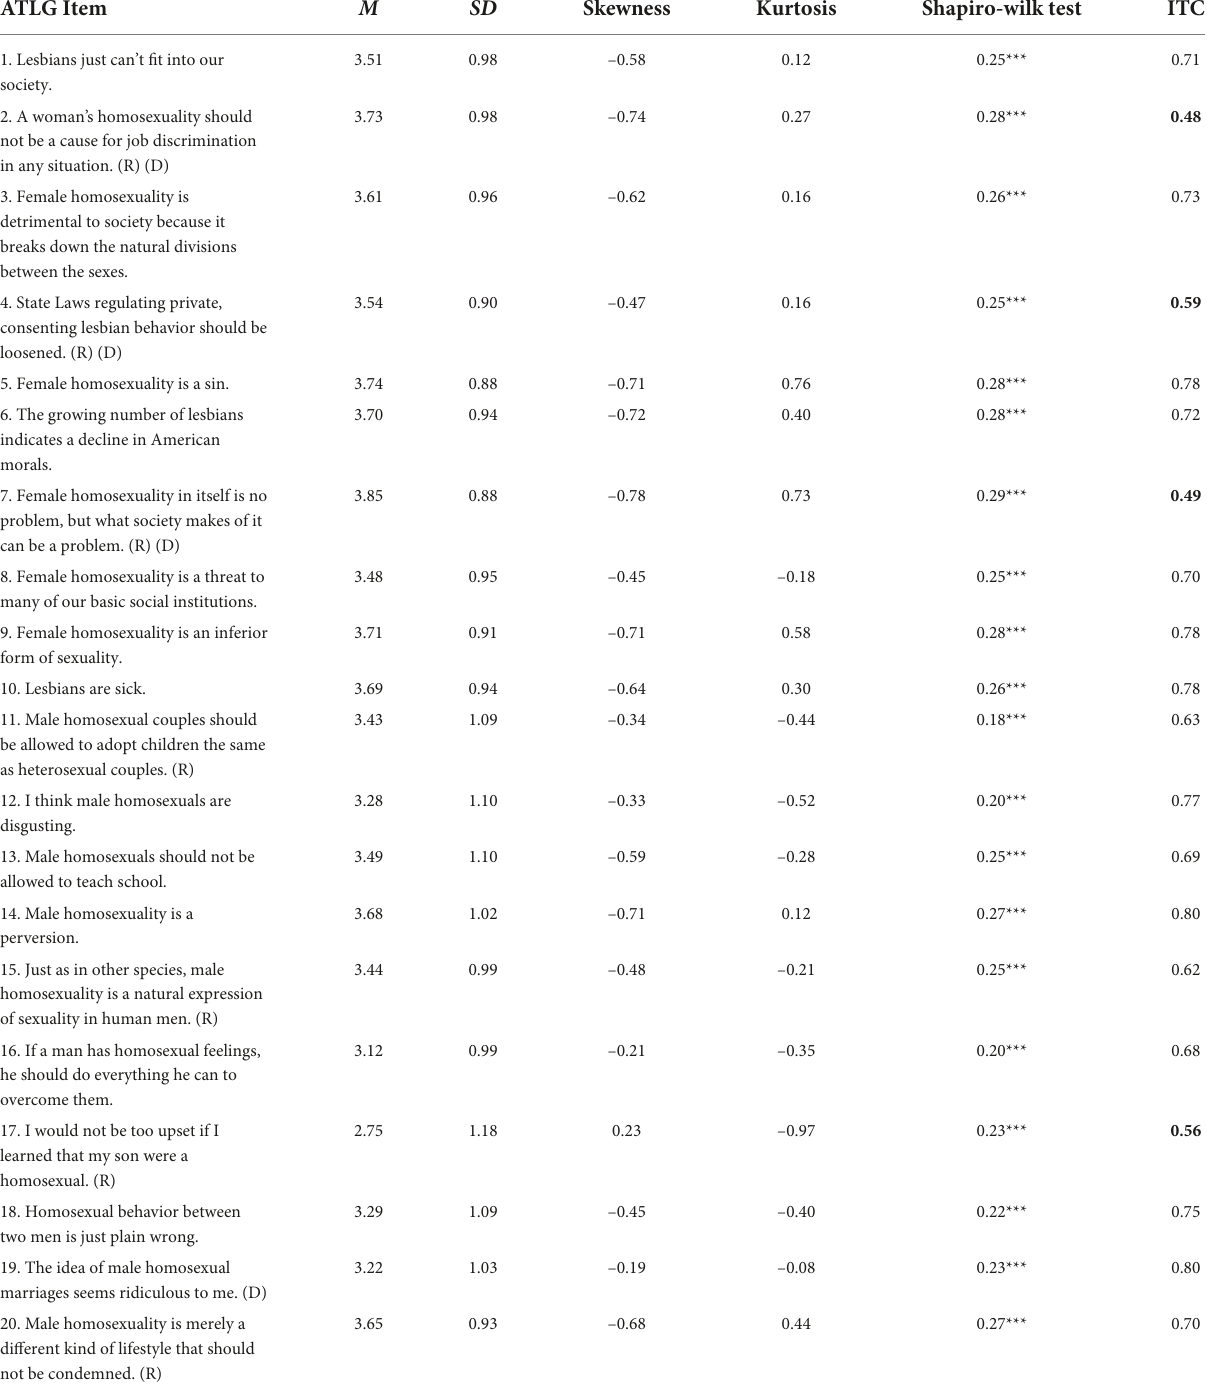
TABLE 1 Item wording, descriptive statistics and item-total correlations of the ATLG scale ( n = 6036). ATLG